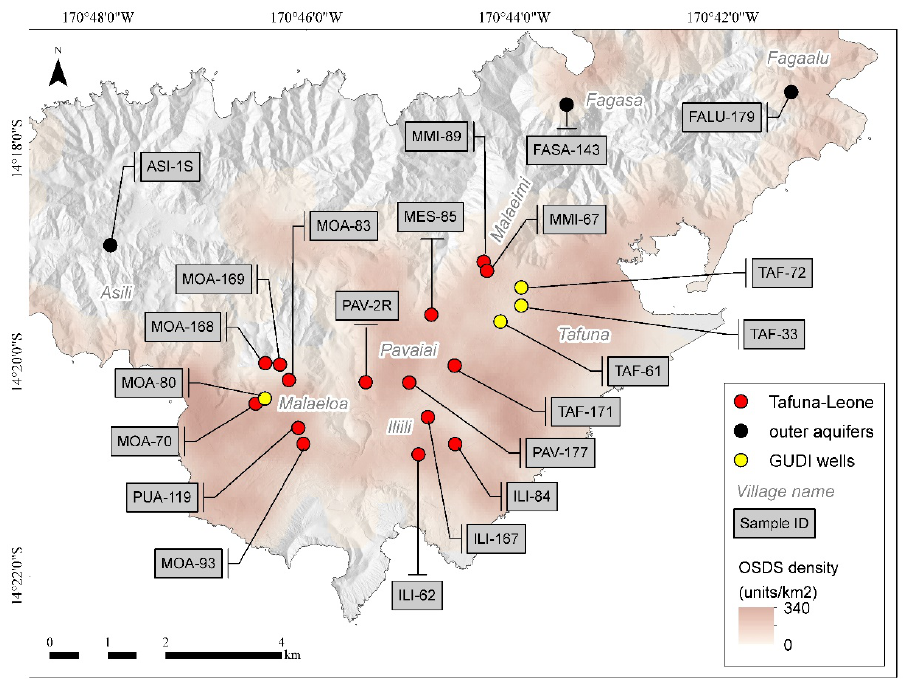
Figure 2. Location map with associated sample names of 22 groundwater samples analyzed for selected ions, nutrients, and trace metals across the Tafuna–Leone Plain, Tutuila, American Samoa. The density map, based on OSDS locations from Shuler et al. [2], highlights the areas of urban development in relation to the sampling. Analysis results can be found in Tables 1 and S1.